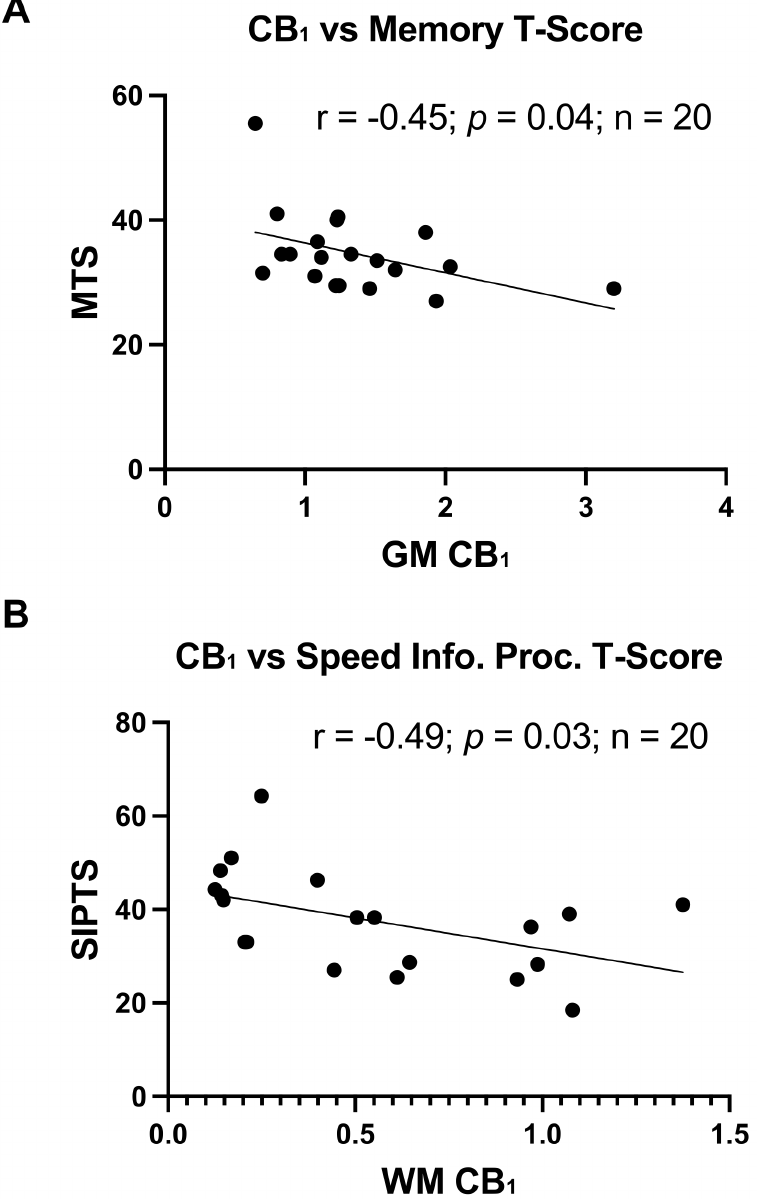
Figure 2. Greater CB 1 expression relates to worse cognitive function: ( A ) Correlation of CB 1 expres- sion in GM with memory T-scores, r = − 0.45, p = 0.04. ( B ) Correlation of CB 1 expression in WM